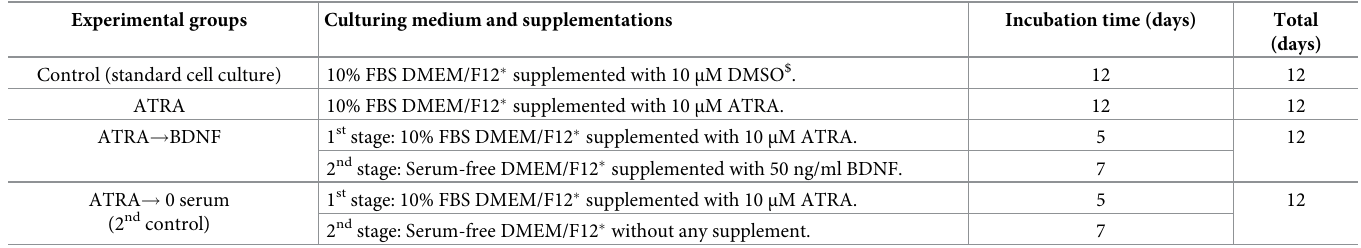
Table 1. Experimental groups (differentiated and control